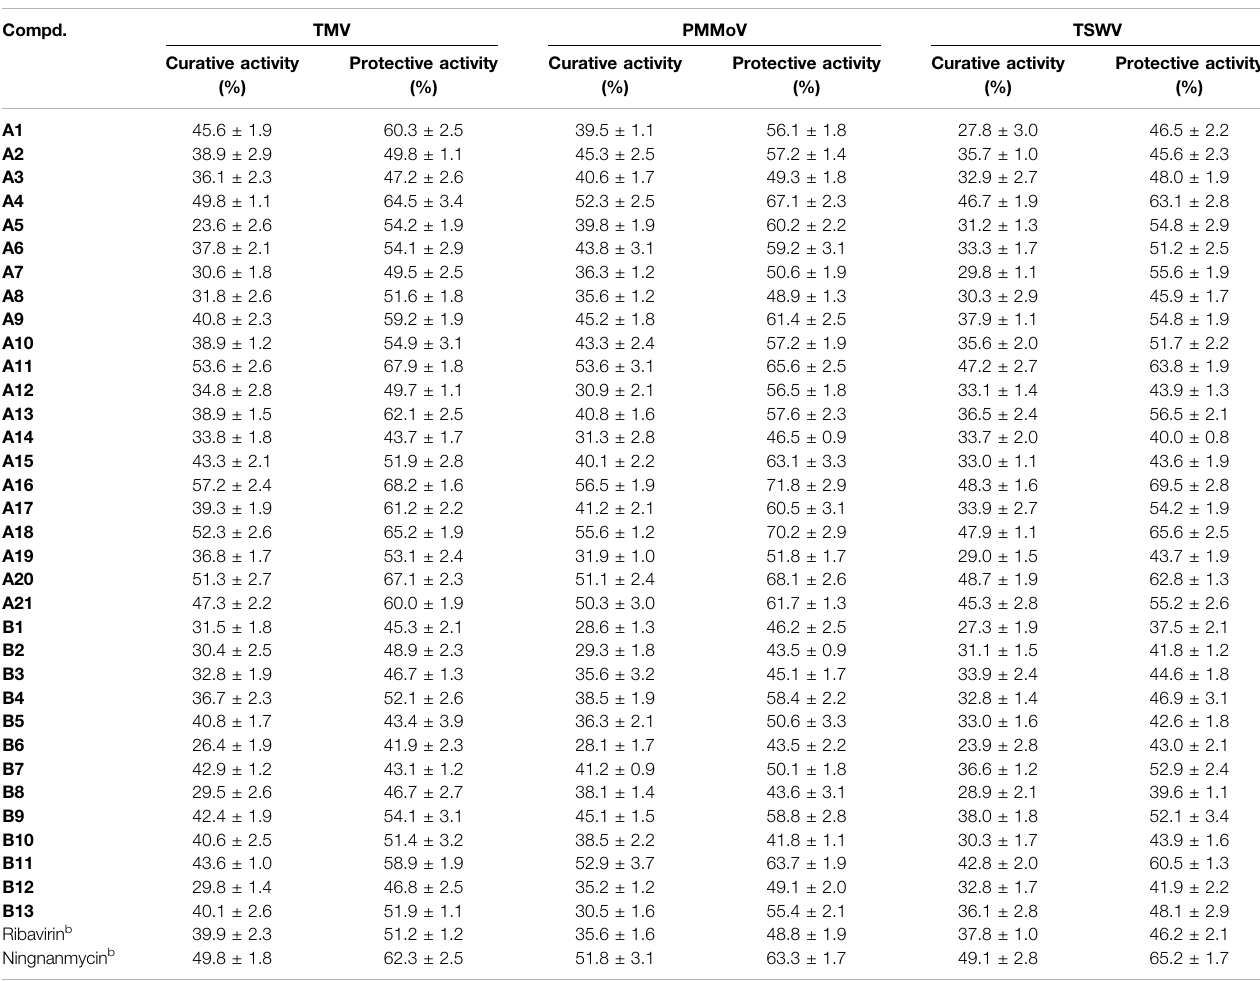
TABLE 4 | Antiviral activities of compounds A1 − A21 and B1 − B13 at 500 μ g/ml. a